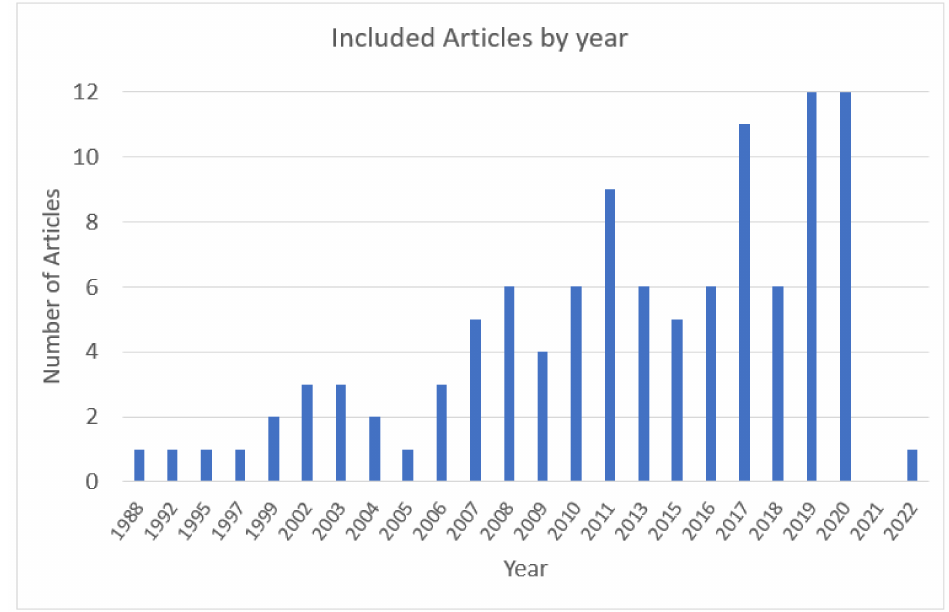
Figure 2. Range of years for studies in this review.